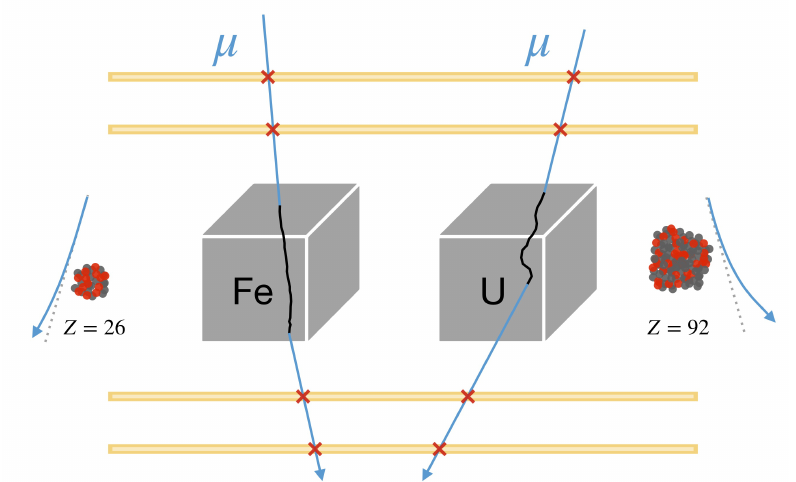
Figure 17. Muon scattering through low-Z and high-Z materials. Scattering amplitudes are exagger- ated for